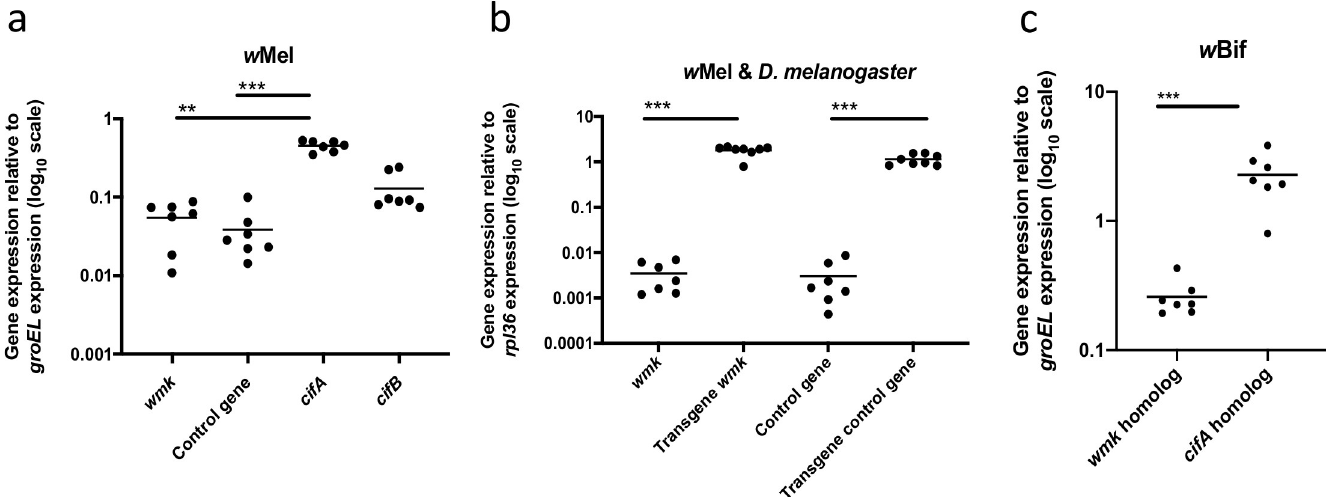
Fig 6. Native Wolbachia gene and transgene expression in embryos of D . melanogaster and D . bifasciata . (A) Graph of native prophage WO and Wolbachia gene expression in w Mel-infected D . melanogaster embryos fixed 4–5 h AED (pooled male & female) compared to Wolbachia gro EL. Each point (n = 7) represents a pool of 30 embryos from a set of 10 mothers and 2 fathers. (B) Graph of (i) transgene expression in uninfected D . melanogaster embryos fixed 4–5 h AED versus (ii) native gene expression in samples from a, both compared to Drosophila rpl 36 (pooled male, female, expressing, and non-expressing for transgenes). Each point (transgene n = 8, native n = 7) represents a pool of 30 embryos from a set of 10 mothers and 2 fathers. (C) Graph of w Bif Wolbachia gene expression in D . bifasciata embryos 4–5 h AED (pooled male & female) compared to Wolbachia groEL . Homologs to the control gene in this study and cifB were not measured as they are not present in the w Bif genome assembly. Each point (n = 7) represents a pool of 30 embryos from a set of 10 mothers and 2 fathers. Values denote 2 - Δ Ct . Statistics are based on a Kruskal- Wallis one-way ANOVA followed by Dunn’s correction. This experiment has been done once. �� p < 0.01, ��� p < 0.001.